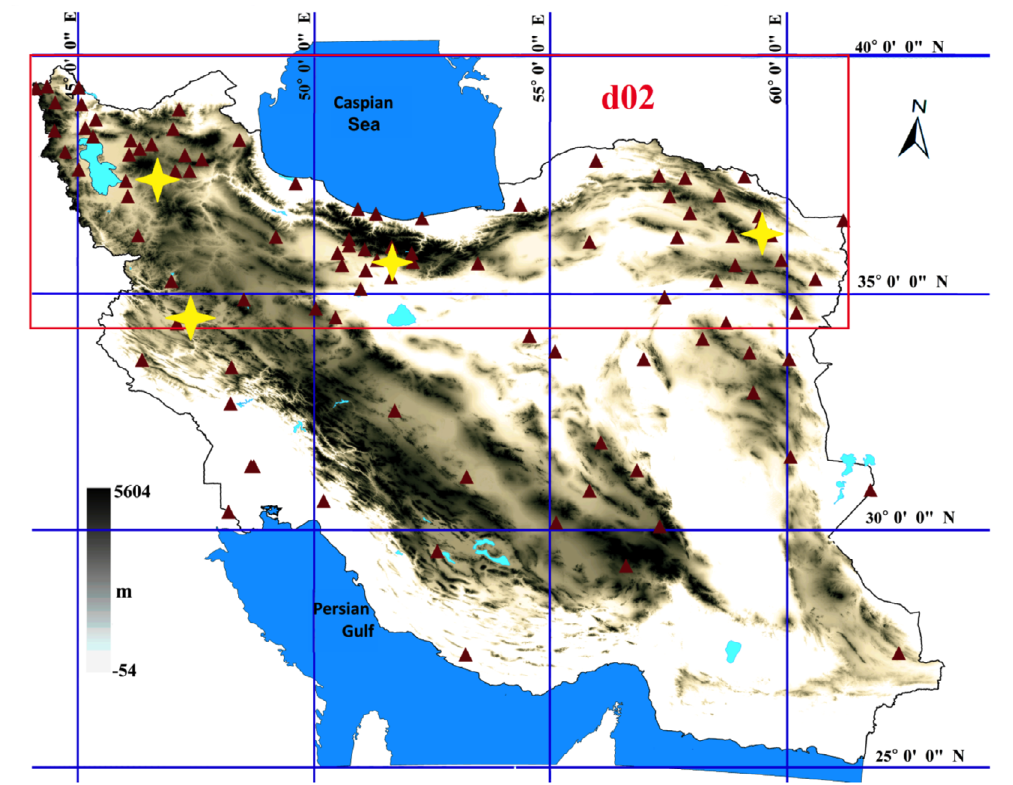
Figure 1. Distribution of IPGN stations together with topographic information over Iran. The red rectangle shows the inner domain of model. The yellow stars show the location of radiosondes in the